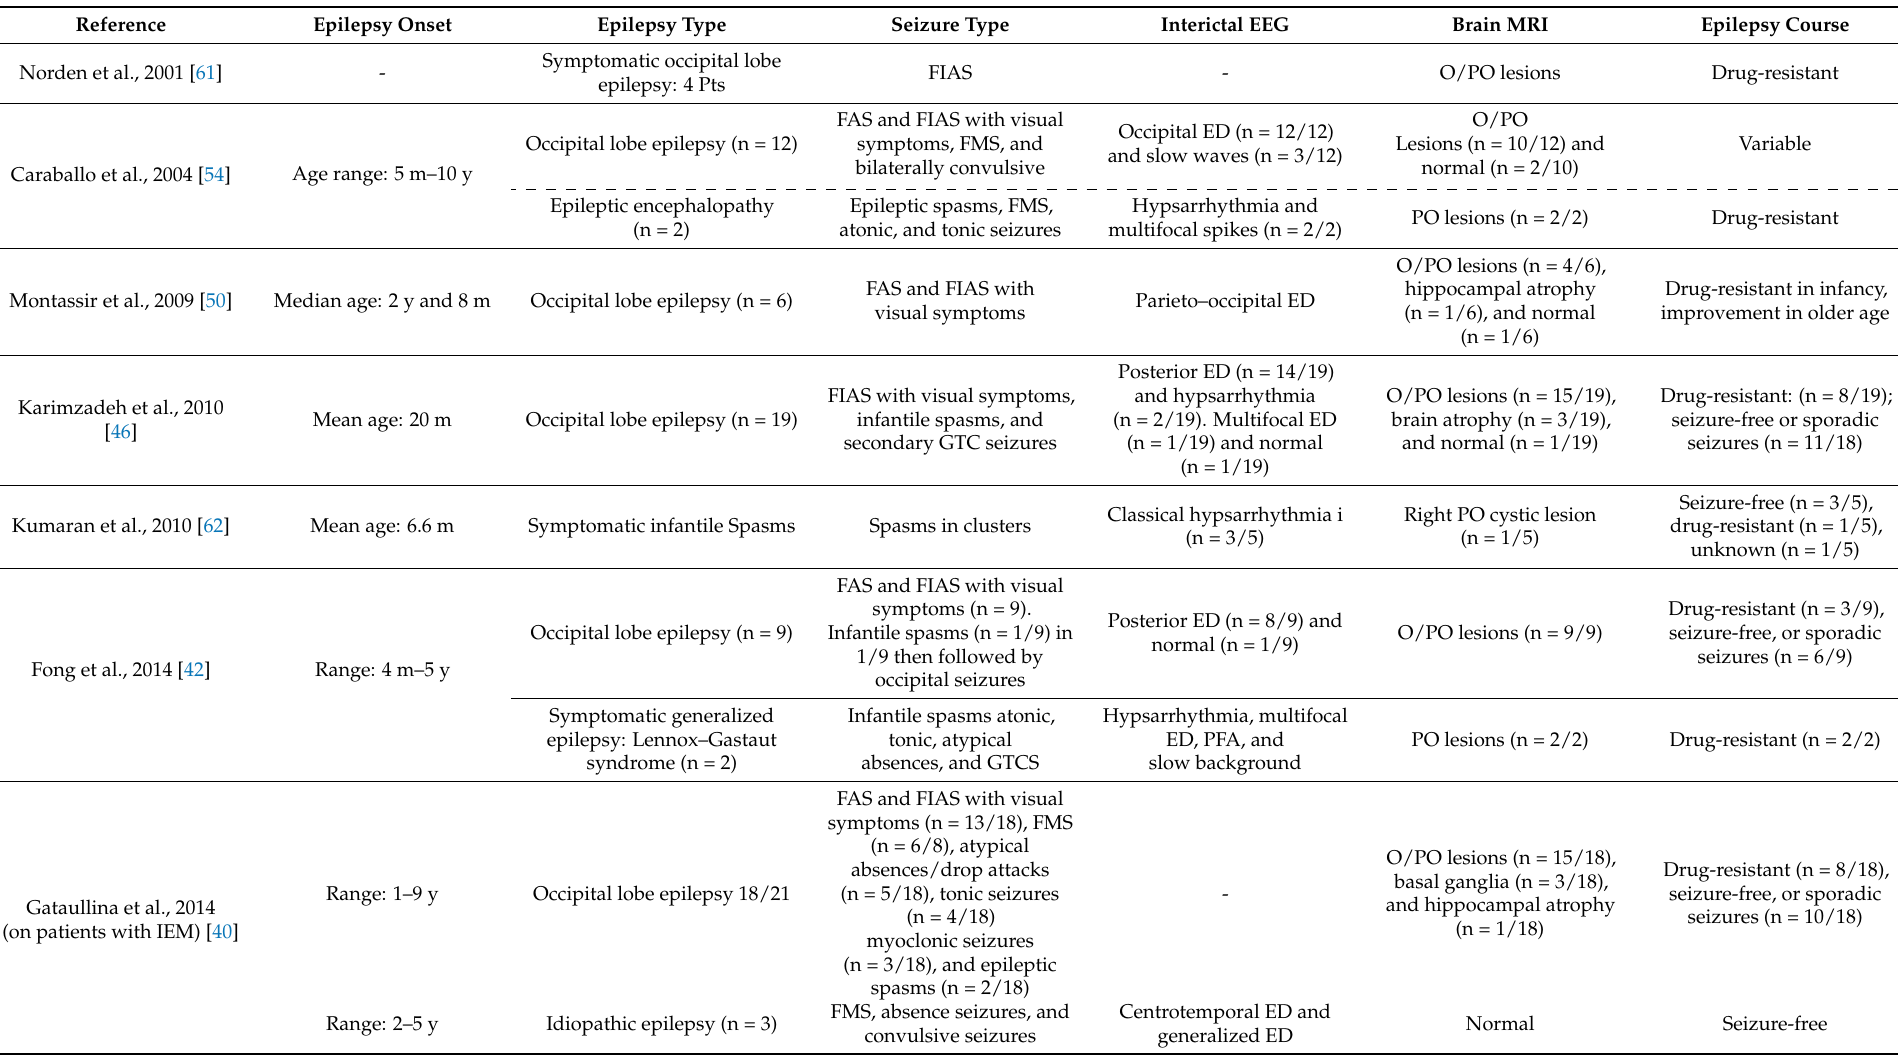
Table 1. Studies on children with seizures/epilepsy resulting from neonatal